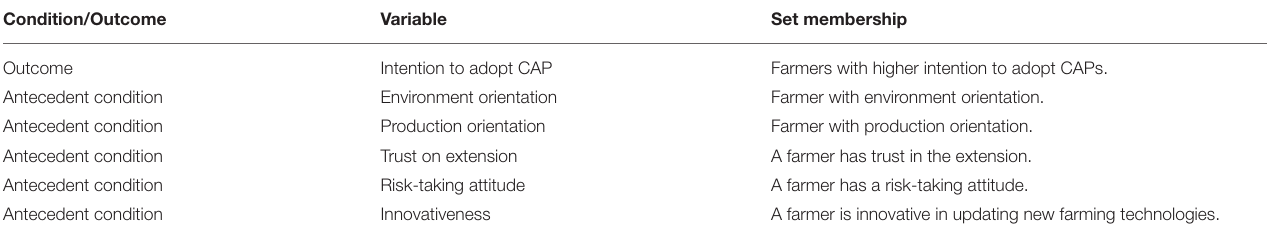
TABLE 1 | Set definitions.